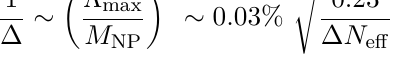
Figure 6 . The age of a given patch as a function of the CC value in it (in units of the observed CC). For this plot we take N = 5 , (cid:15) 2 = 2 , and λ = 1 / 30 , which leads to T ∗ ’ 0 . 8 T (0) other parameters at their nominal values (see appendix C.3). The plot shows that as time passes, only patches with increasingly smaller values of the CC survive. For the parameters taken here, by t ’ 17 Gyr all patches are predicted to crunch regardless of their CC